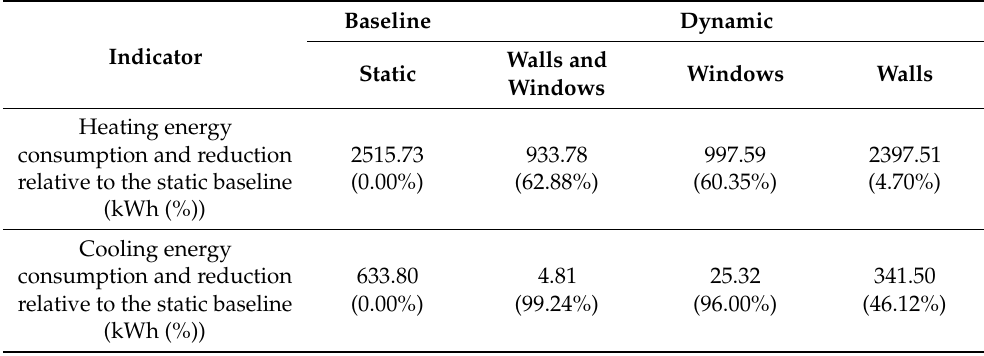
Table 11. Annual heating and cooling energy consumption for static and SIS walls and windows applied to a detached house in Barcelona,